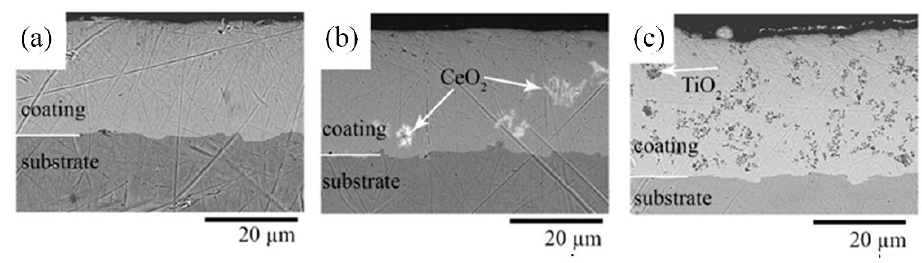
Figure 5. Cross-sectional SEM images of Ni ( a ), Ni-CeO 2 ( b ), and Ni-TiO 2 ( c ) coatings .